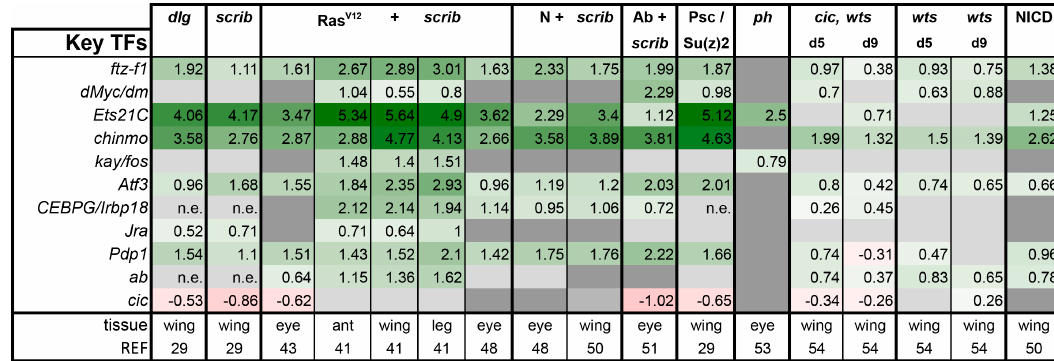
Figure 8. Expression of select transcription factors (TFs) across tumors. Gene expression is displayed in log2FC. Color coding corresponds to a heatmap with a scale from − 5 (dark red) to 5 (dark green). Light grey cells represent non-significant changes with p ≥ 0.05. Dark grey: the gene was not found in the datasets. n .e. = not expressed, the gene was in the data, but showed 0 reads. Abbreviations: ftz transcription factor 1, ftz-f1; diminutive, dm; Ets at 21C, Ets21c; chronologically inappropriate morphogenesis, chinmo; kayak, kay; Activating transcription factor 3, Atf3; CCAATT Enhancer Binding Protein Gamma, CEBPG; Inverted repeat binding protein 18, Irbp18; Jun-related antigen, Jra; PAR-domain protein 1, Pdp1; abrupt, ab; capicua, cic.